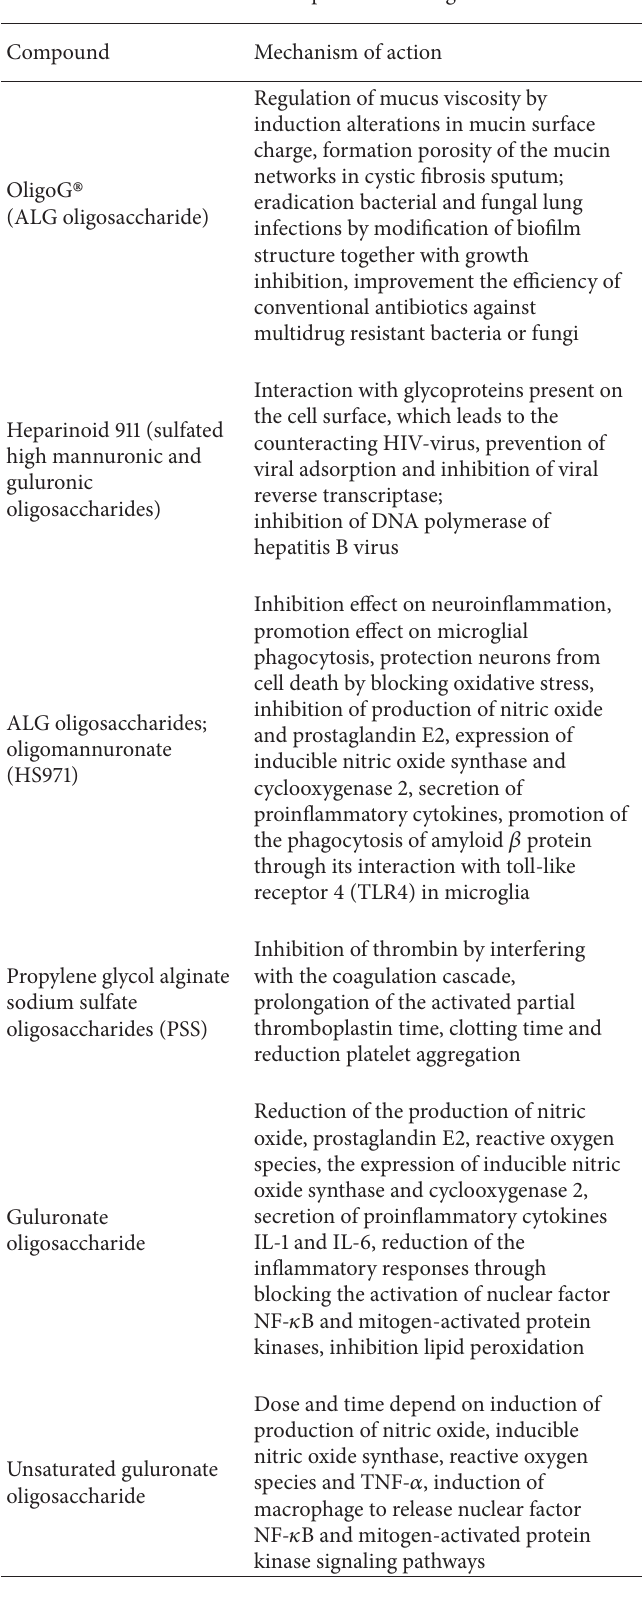
Table 5: Examples of ALG oligosaccharides with biological activity and pharmaceutical